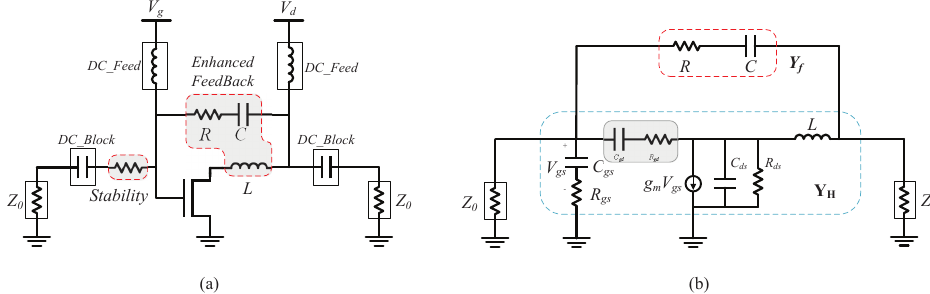
Figure 1. ( a ) The source and load-pull setup of the proposed structure. ( b ) Equivalent circuit model of the proposed structure.